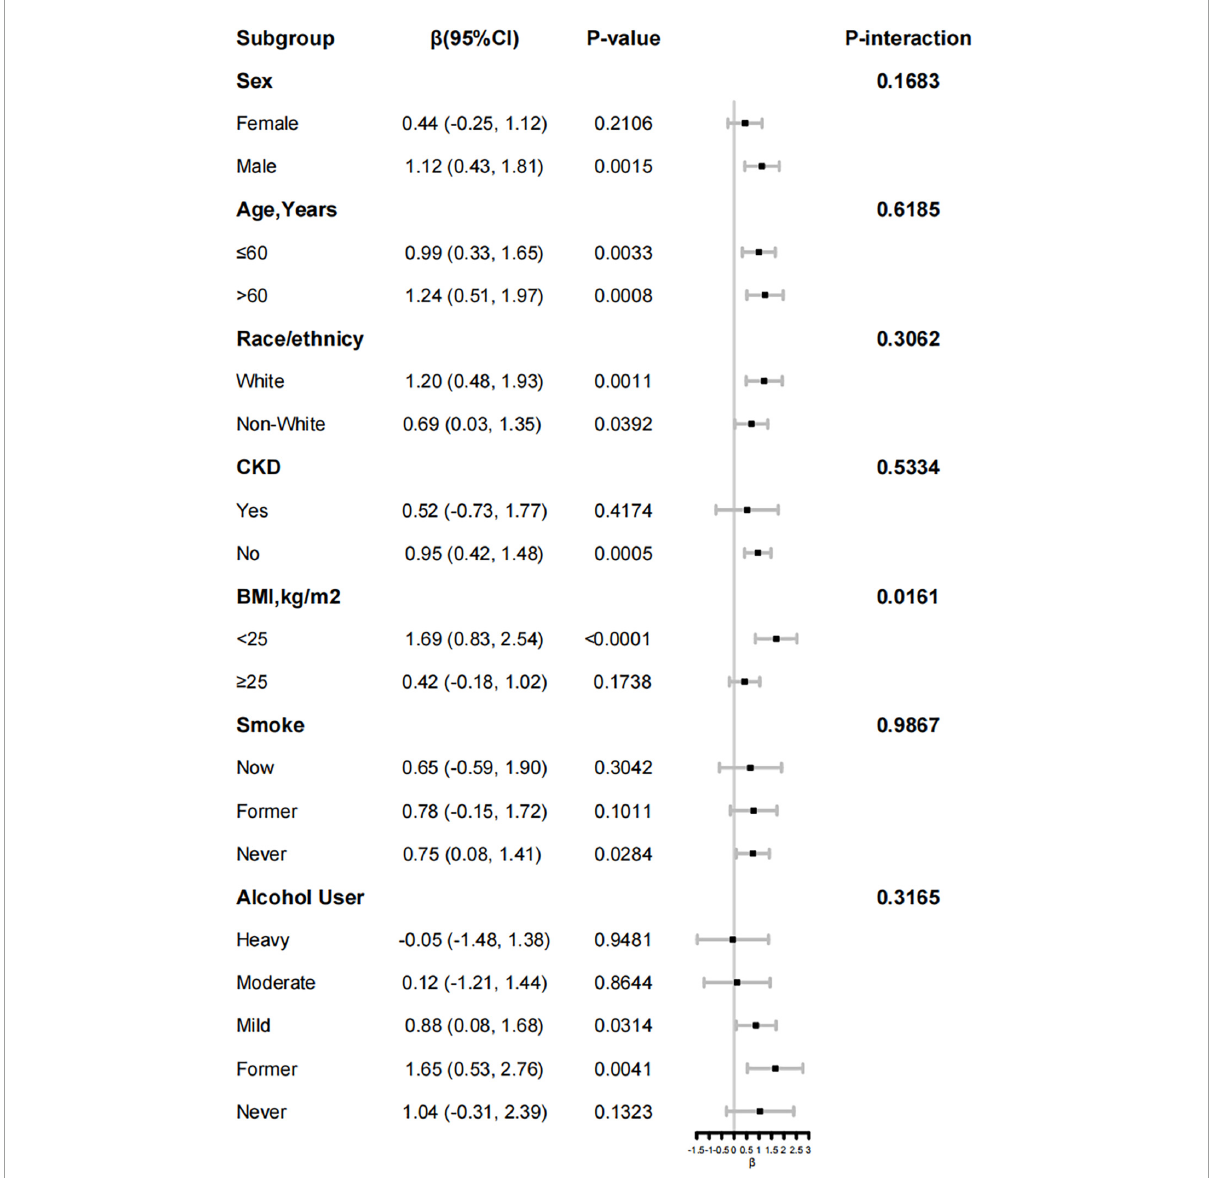
FIGURE2 Forest plots of stratified analyses of Healthy Eating Index (HEI)-2015 and